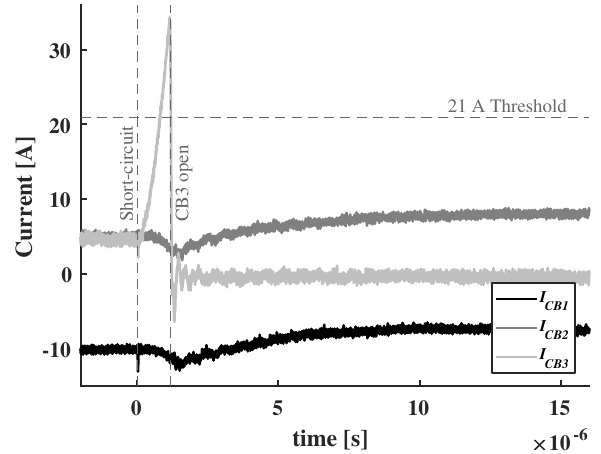
Figure 18. Experimental results for the system shown in Figure 10, showing that fault propagation is delayed with the plug-and-play